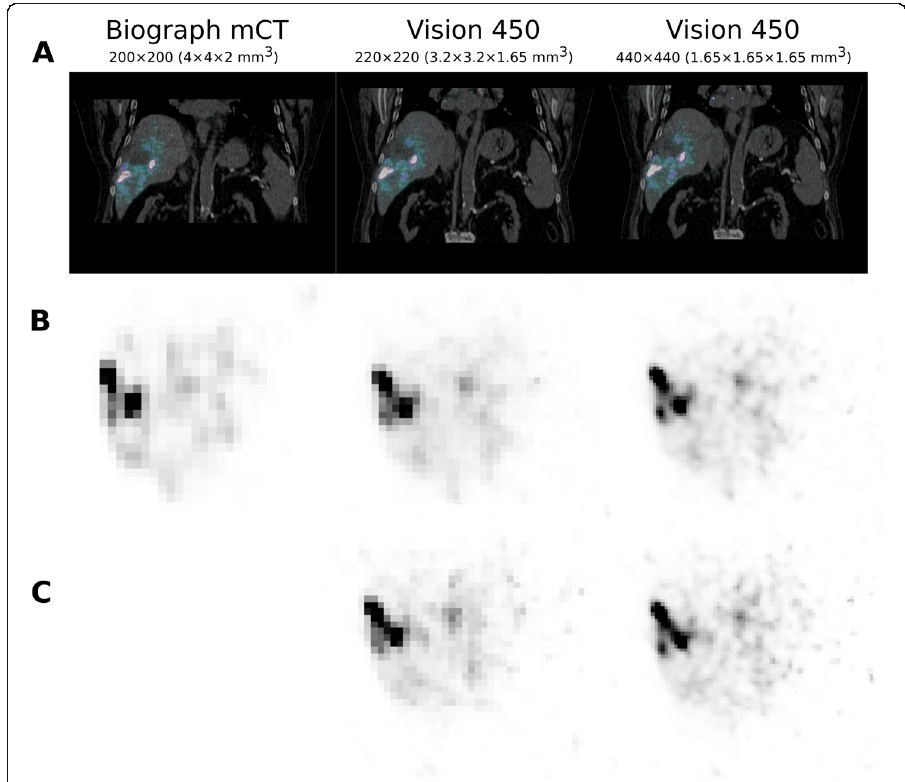
Fig. 8 Patient with segment VII hepatocellular carcinoma. The radioembolization was for the management of a local recurrence including several satellite nodules. The acquisition time was 30 min for mCT and Vision (injected activity 2251 MBq of 90 Y-microspheres). The reconstruction parameters were OP-OSEM+PSF + TOF, 3 iterations, 21 subsets, and no post-filtering for mCT (200 × 200 matrix size) and OP-OSEM+PSF + TOF, 4 iterations, 5 subsets, and no post-filtering for Vision. Biograph mCT and Vision 450 images were co- registered using rigid transformation. a Fused coronal slice, b selected transaxial slice using full time acquisition for each case, c selected transaxial slice using 15 min 52 s (reduction factor 1.89) for Vision using the 220 × 220 matrix size (middle) and 22 min 23 s (reduction factor 1.34) for Vision using the 440 × 440 matrix size. Grey scale was